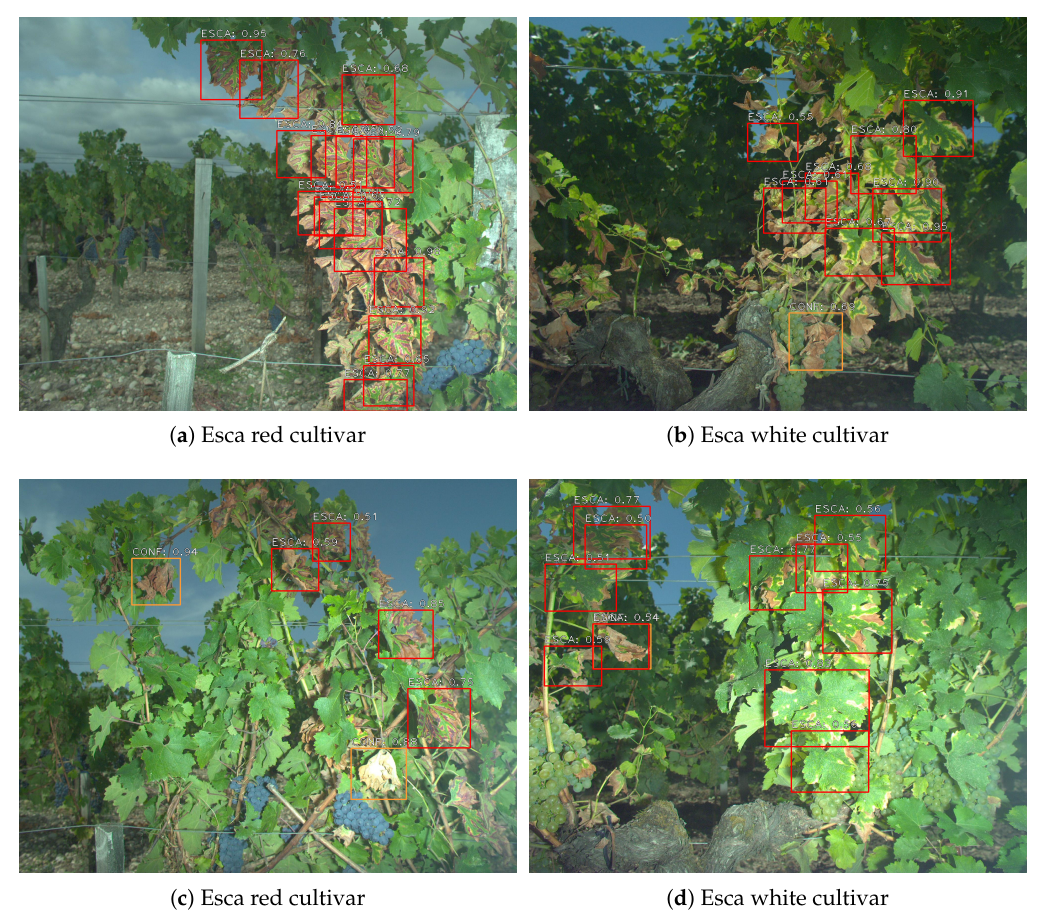
Figure 12. Examples of detection maps using 1500 pixel images with data augmentation during training and 0.5 classification threshold. ( a , c ) Esca on red cultivar. ( b , d ) Esca on white